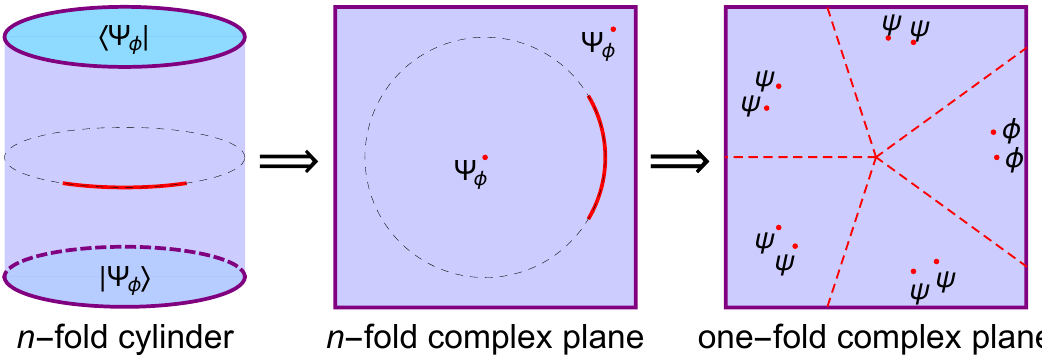
). Here (cid:9) (cid:30) (cid:17) (cid:30) 0 Q n (cid:0) 1 , with (cid:30) existing in one copy j =1 j A;